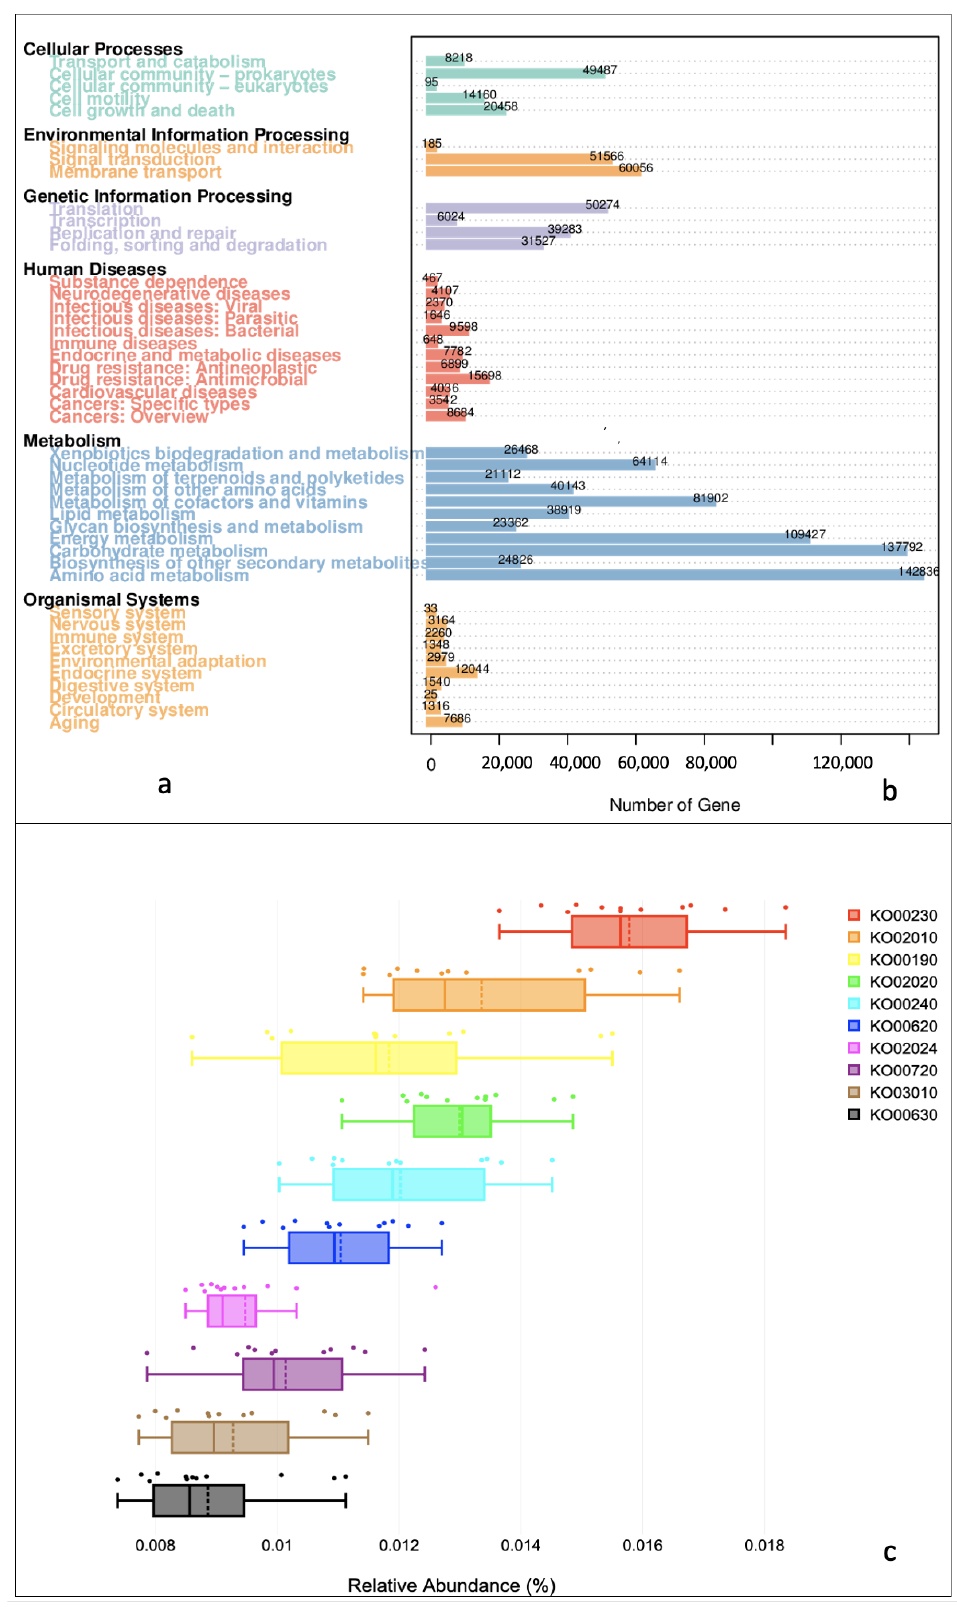
Figure 5. Functional annotation by KEGG database. ( a ) Level 1 and 2 metabolic pathways detected in marine sediments of Kuwait. ( b ) Number of genes associated with level 2 KEGG pathways. ( c ) Box plots showing relative abundances of top 10 level 3 KEGG pathways.